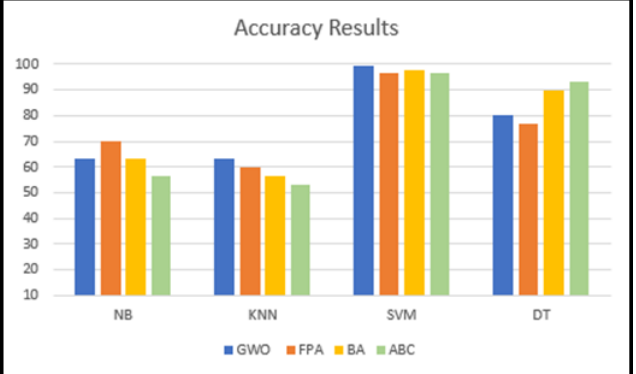
Figure 4. Comparison of accuracy between proposed models on the GE dataset.